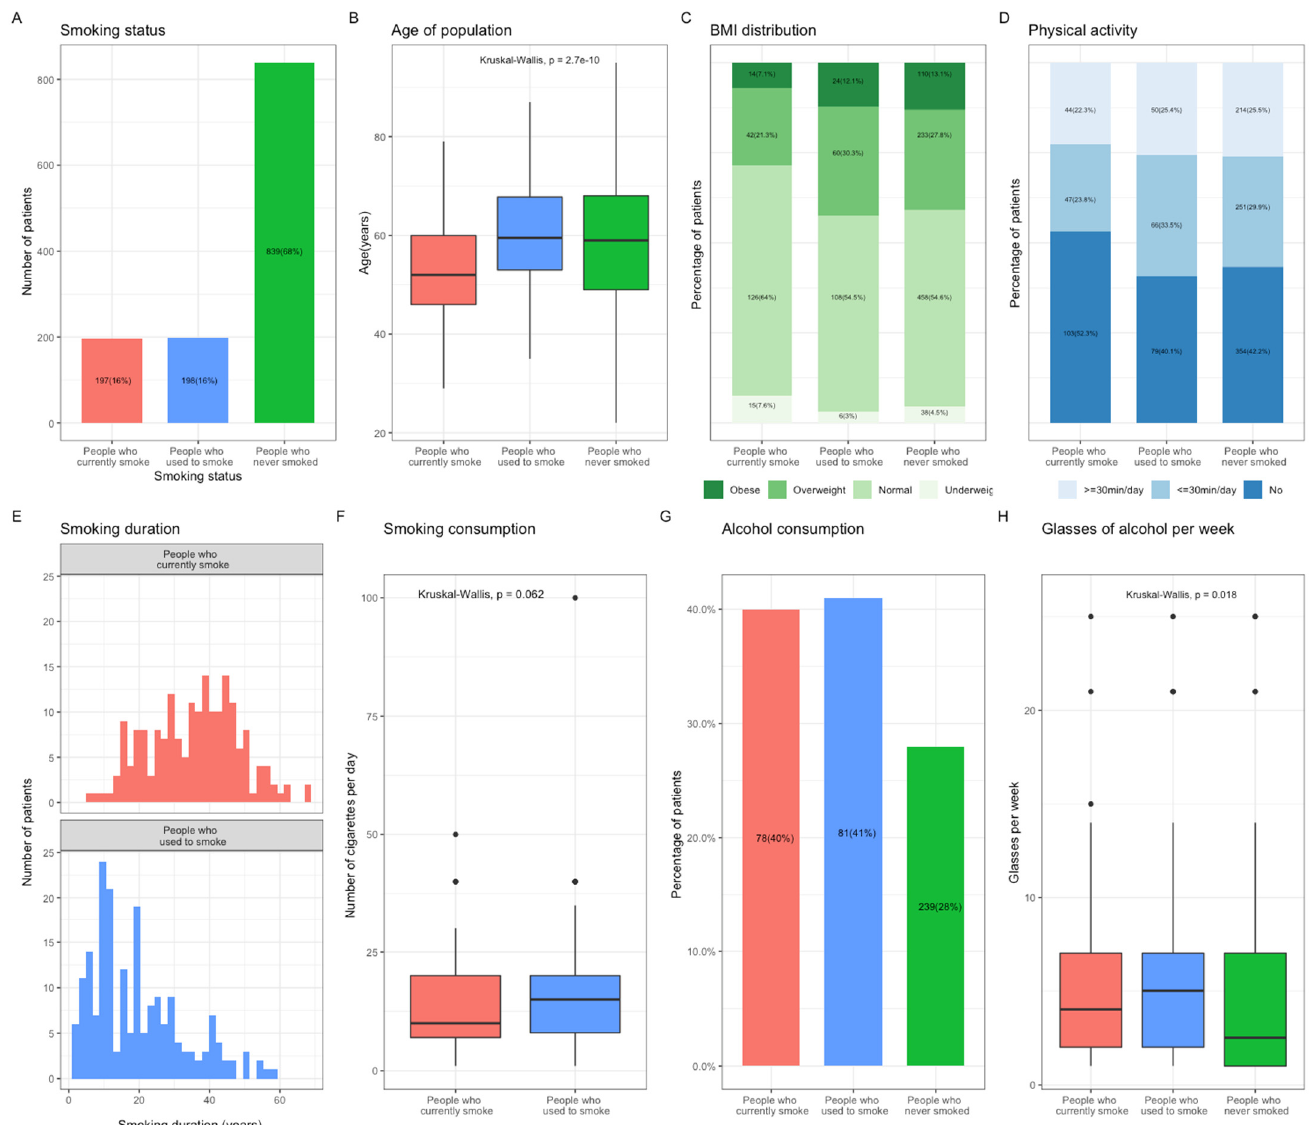
Figure 1. Population characteristics according to smoking status at the time of Breast Cancer (BC) diagnosis. ( A ), Repartition of the population according to smoking status at diagnosis. ( B ), Mean age of the population according to smoking status at diagnosis. ( C ), Bar plot representing the BMI distribution in the population according to smoking status at diagnosis. Subcategories were defined as followed: Obese, BMI > 30 kg/m 2 ; Overweight, BMI > 25 kg/m 2 ; Normal, 18 kg/m 2 < BMI < 25 kg/m 2 ; Underweight, BMI < 18 kg/m 2 . ( D ), Bar plot representing the physical activity in the population according to smoking status at diagnosis. Subcategories were defined as followed: Yes, more or less than 30 min per day; No. ( E ), Smoking duration in patients who currently smoke, and those who used to smoke at diagnosis. ( F ), Mean smoking consumption in patients who currently smoke and those who used to smoke at diagnosis. ( G ), Bar plot representing the patients’ alcohol consumption according to smoking status at diagnosis. ( H ), Mean number of alcohol glasses consumed per week according to smoking status at diagnosis. Abbreviation: BC, breast cancer; BMI, body mass index.